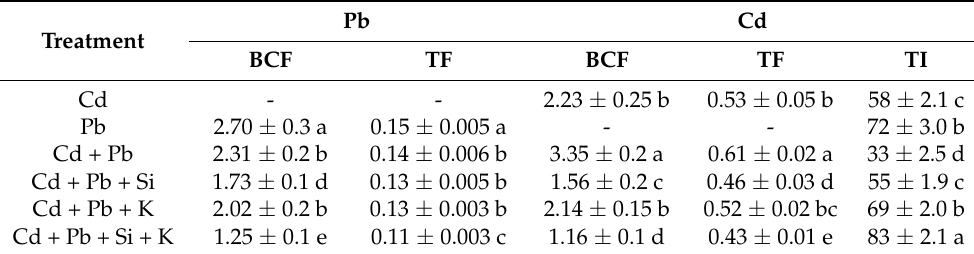
Table 3. Bioconcentration factor (BCF), translocation factor (TF) and tolerance index (TI) of quinoa plants under Cd and Pb treatments with and without supplementation with Si and